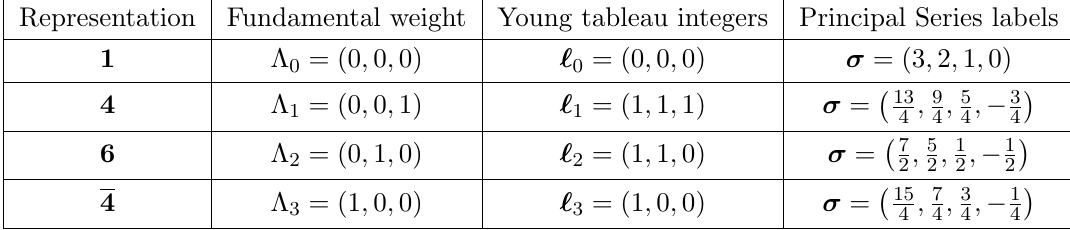
Table 1 . Various labels for the fundamental representations of sl